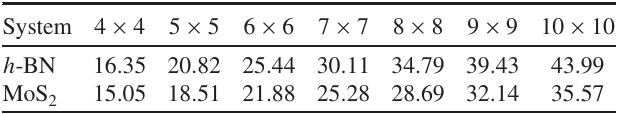
TABLE I. Special vacuums L s z (in Å) for different lateral supercell sizes (in multiples of the primitive cell) of monolayer h -BN and MoS 2